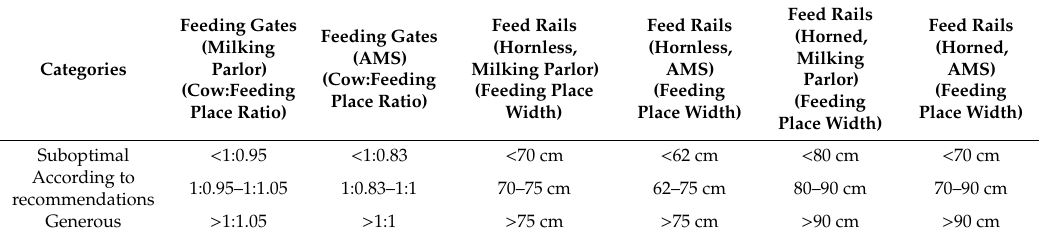
Table A5. Feeding places—categories for analyses derived from